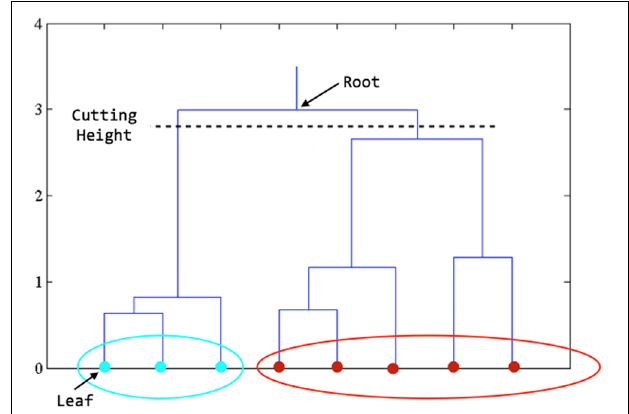
FIGURE 2 | Dendrogram derived from hierarchical clustering. The final clustering result is obtained by cutting the tree at the defined level. In the figure above, when the tree is cut at the level shown, we get the features in teal color in one cluster and those in red color in another